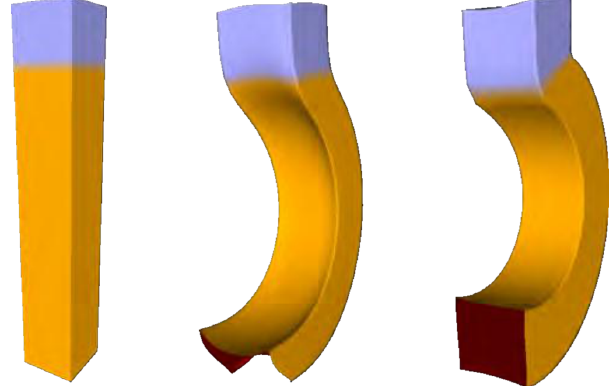
The post (left) is rotated locally at the selected vertices to become a hook. The AnARAP approach (middle) exhibits more global deformation while AnDefGrad (right) has more local control.